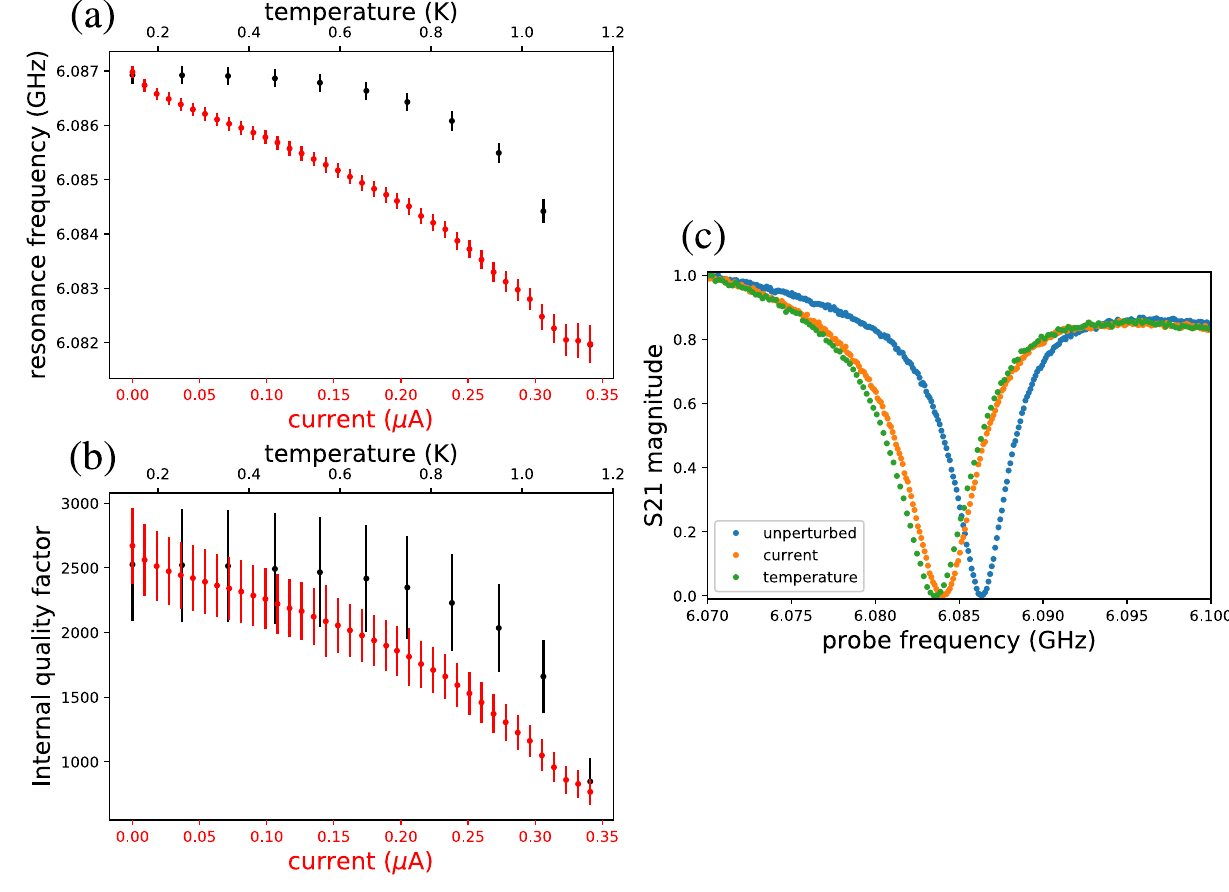
Figure 3. ( a ) Measured resonance frequency and ( b ) internal quality factor of the resonator as functions of the bias current (red color) while keeping the bath temperature at 20 mK and as functions of the bath temperature (black color) with no bias current. ( c ) Magnitude of the normalized transmission coefficient as a function of probe frequency under finite bias current (orange), elevated temperature (green), and not perturbations